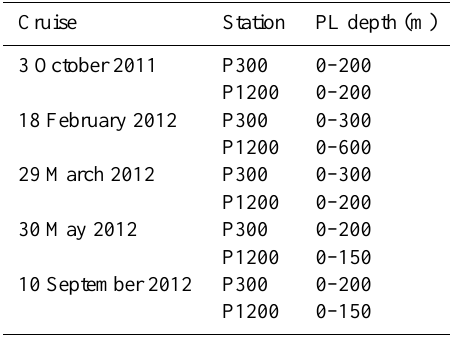
Figure 4. Vertical distribution of dissolved inorganic nitrogen (DIN), chlorophyll a (Chl a ) and heterotrophic prokaryotes abun- dance (HP) at stations P300 and P1200 during the cruises (3 Oc- tober 2011, 18 February 2012, 29 March 2012, 30 May 2012, 10 September